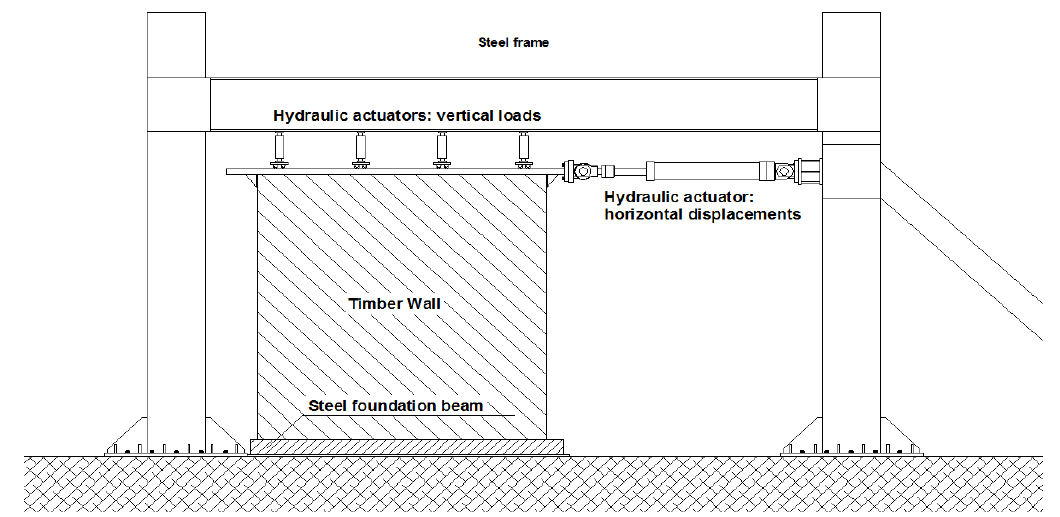
Figure 6. Test set-up: steel frame, hydraulic actuator, vertical load system, and